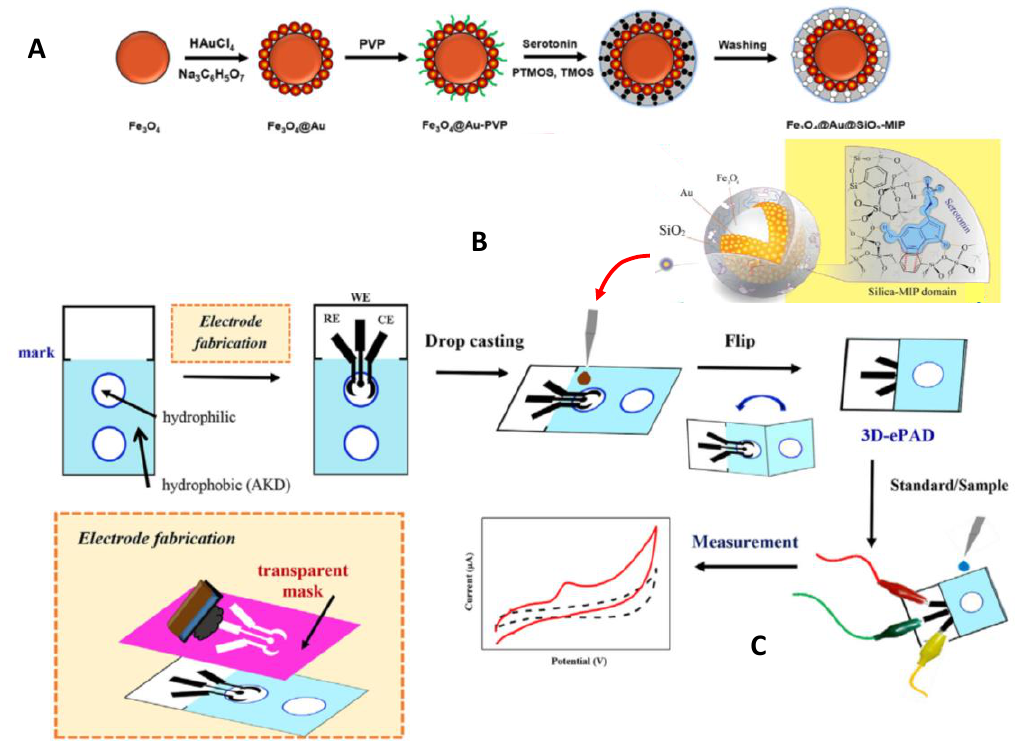
Figure 3. ( A ) Synthesis of Fe 3 O 4 @Au@SiO 2 -MIP, ( B ) preparation of the sensor for serotonin, and ( C ) electrochemical detection using the 3D-ePAD. Reproduced and adapted with permission of Elsevier [30].